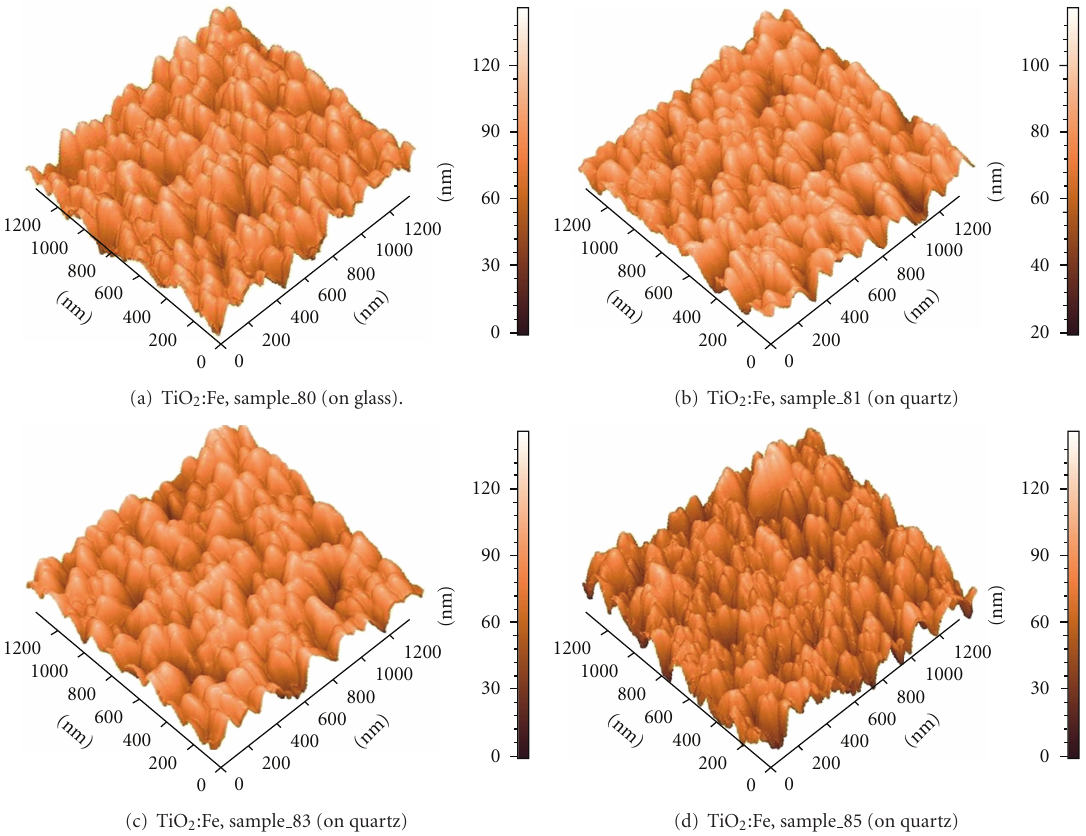
(b) TiO 2 :Fe, sample 81 (on quartz)